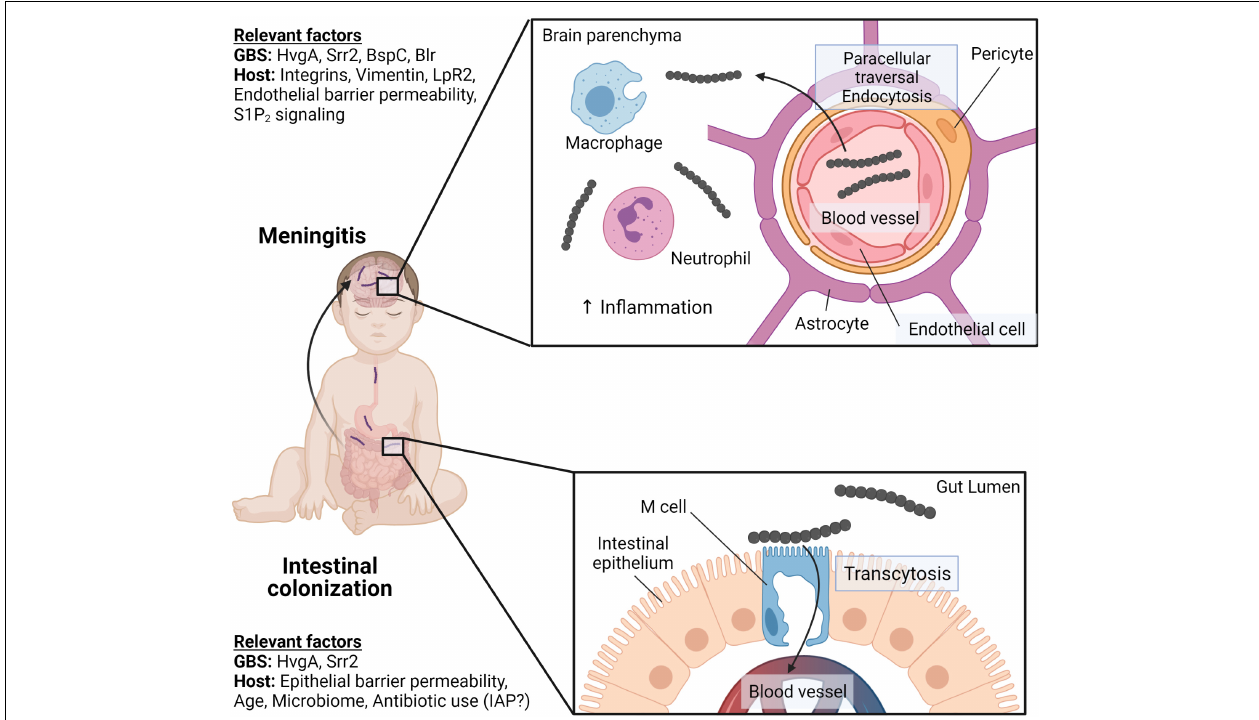
FIGURE 4 | GBS intestinal colonization and meningitis in neonates. Neonates can acquire GBS through vertical transmission or community sources resulting in intestinal colonization. Both GBS proteins, HvgA and Srr2, facilitate adhesion to the intestinal epithelium. However, only Srr2 engages with M cells in Peyer’s patches to facilitate GBS crossing of the intestinal barriers through M cell transcytosis. GBS can gain access to the brain through the bloodstream and crossing the blood–brain barrier (BBB). Srr2 interacts with integrins that are overexpressed in the postnatal brain to adhere to brain endothelial cells. GBS enters endothelial cells via endocytosis and can induce endothelial-mesenchymal transition to facilitate BBB disruption. GBS BspC binds to host vimentin and stimulates phagocyte recruitment and brain inflammation. Created with